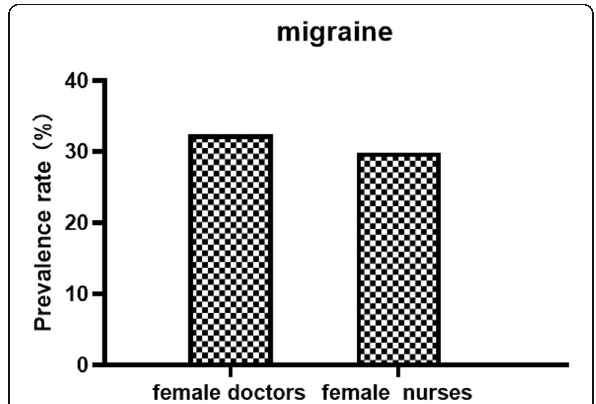
Fig. 2 Comparison of the prevalence of migraine among female doctors and female